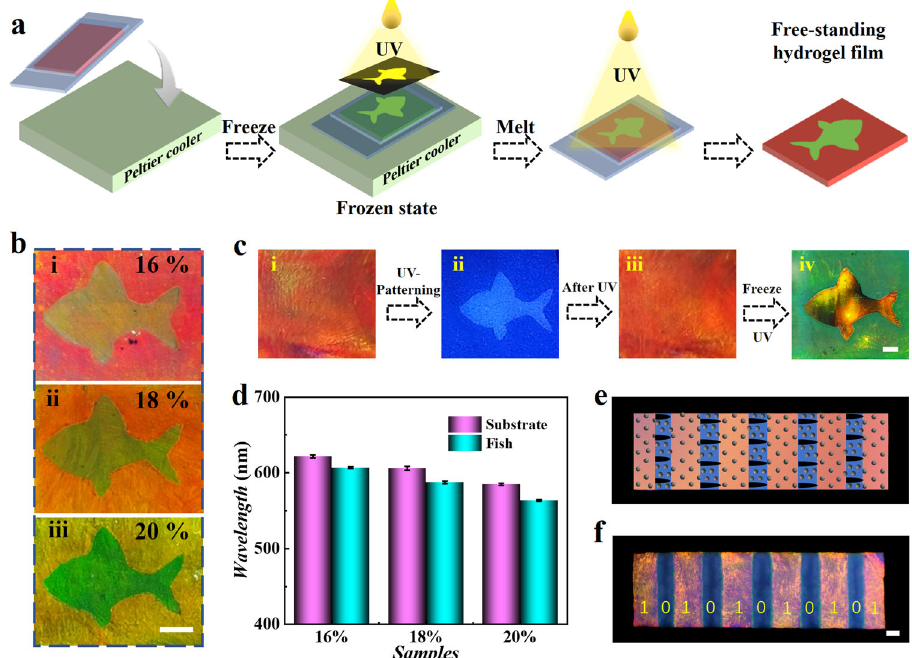
Fig. 6 Heterogeneous structural color hydrogels with designed freezing geometries. a Schematic illustration of preparing heterogeneous structural color hydrogels possessing dual-color compartments. b , d Optical images ( b ) and corresponding re fl ection peak wavelengths ( d ) of patterned structural color hydrogel with various nanoparticles solution concentration. c (i-iii) The suspension fi lm was spatially irradiated by UV light via masks to construct a fi sh pattern; (iv) the hidden pattern was displayed via freeze-photopolymerization method. e, f Schematic illustration ( e ) and optical images ( f ) of structural color hydrogels with bar coding geometry. Binary code: 10101010101 2 = 1365 10 . The error bars represent the standard deviations calculated from three specimens. Scale bars are 2 mm in ( b ), 1 mm in ( c ), and 500 μ m in ( f